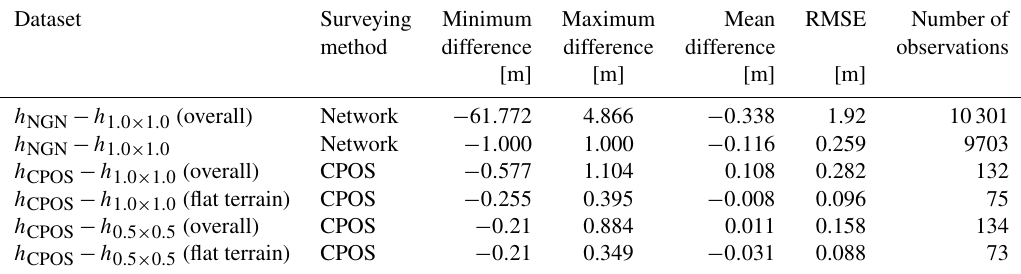
Table 8. Comparisons of heights from DEMs and heights observed by GNSS. Two DEMs have been assessed, i.e., a nationwide DEM